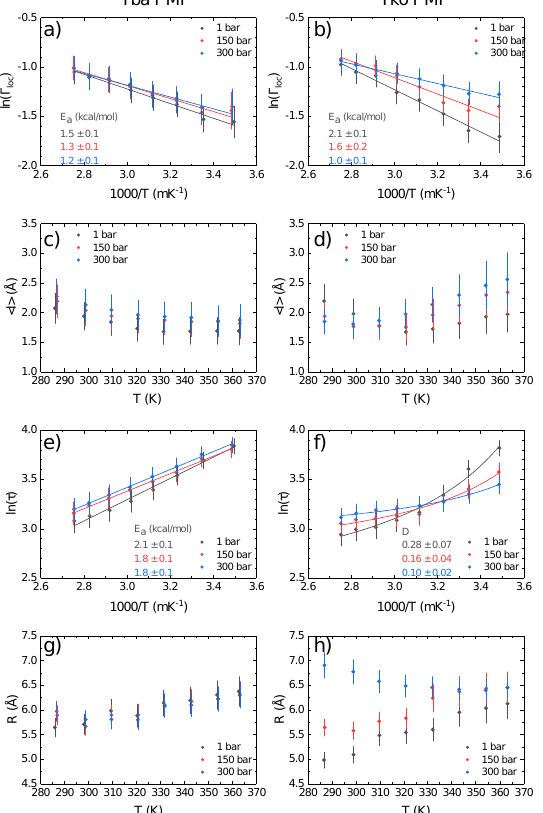
Figure 7. Natural logarithm of the broad component HWHM as a function of inverse temperature for Tba PMI ( a ) and Tko PMI ( b ) at all pressure values. Lines are linear fittings assuming an Arrhenius behaviour. Activation energy values are reported on the figure color-coded with the plots. Mean jump length from the Hall–Ross model as a function of temperature and pressure for Tba PMI ( c ) and Tko PMI ( d ). Natural logarithm of the residence time as a function of inverse temperature at all pressure values. Lines are fits to the Arrhenius law (( e ), Tba PMI) or to the Vogel–Fulcher–Tamman law (( f ), Tko PMI). Values for the activation energy (Tba PMI) and the fragility index (Tko PMI) are reported on the figure color-coded with the plots. Values of confinement radius R for Tba PMI ( g ) and Tko PMI ( h